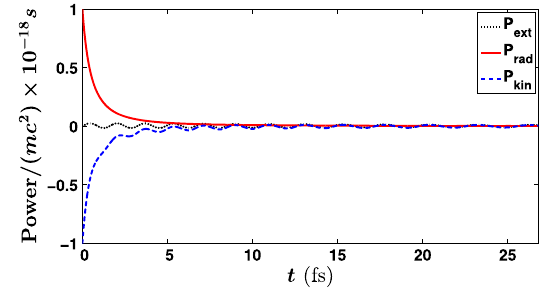
FIG. 10. P , P , and P plotted vs time t for a uniform ext rad kin circularly polarized laser with angular frequency ω ¼ ¼ 100 ( E ¼ 1 ), and an electron 2 × 10 15 s − 1 and strength a 0 with initial relativistic factor γ 0 ¼ 1000 .